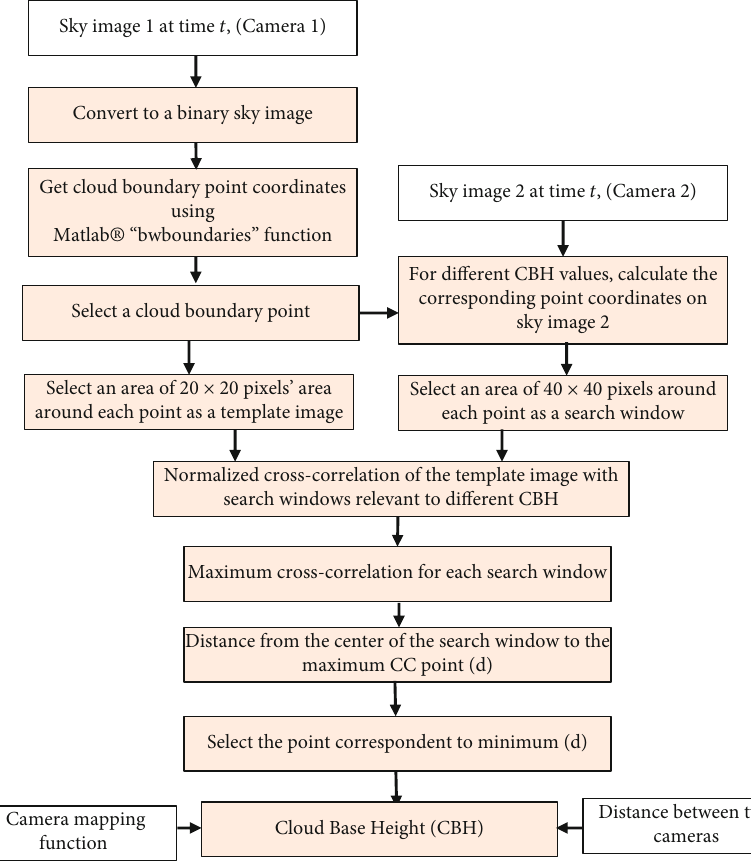
Figure 4: Flow diagram of the CBH calculation method (relevant to Figure 2(f)).